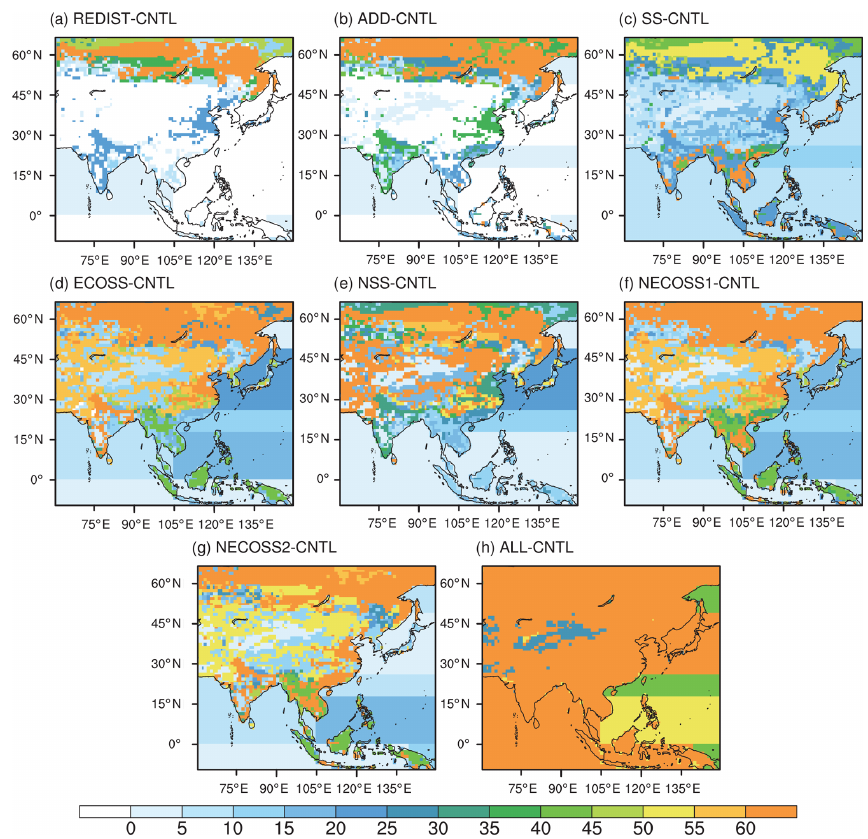
Figure 10. The spatial distribution of uncertainty reduction (%) for (a) the REDIST, (b) the ADD, (c) the SS, (d) the ECOSS, (e) the NSS, (f) the NECOSS1, (g) the NECOSS2, and (h) the ALL experiment, against the CNTL